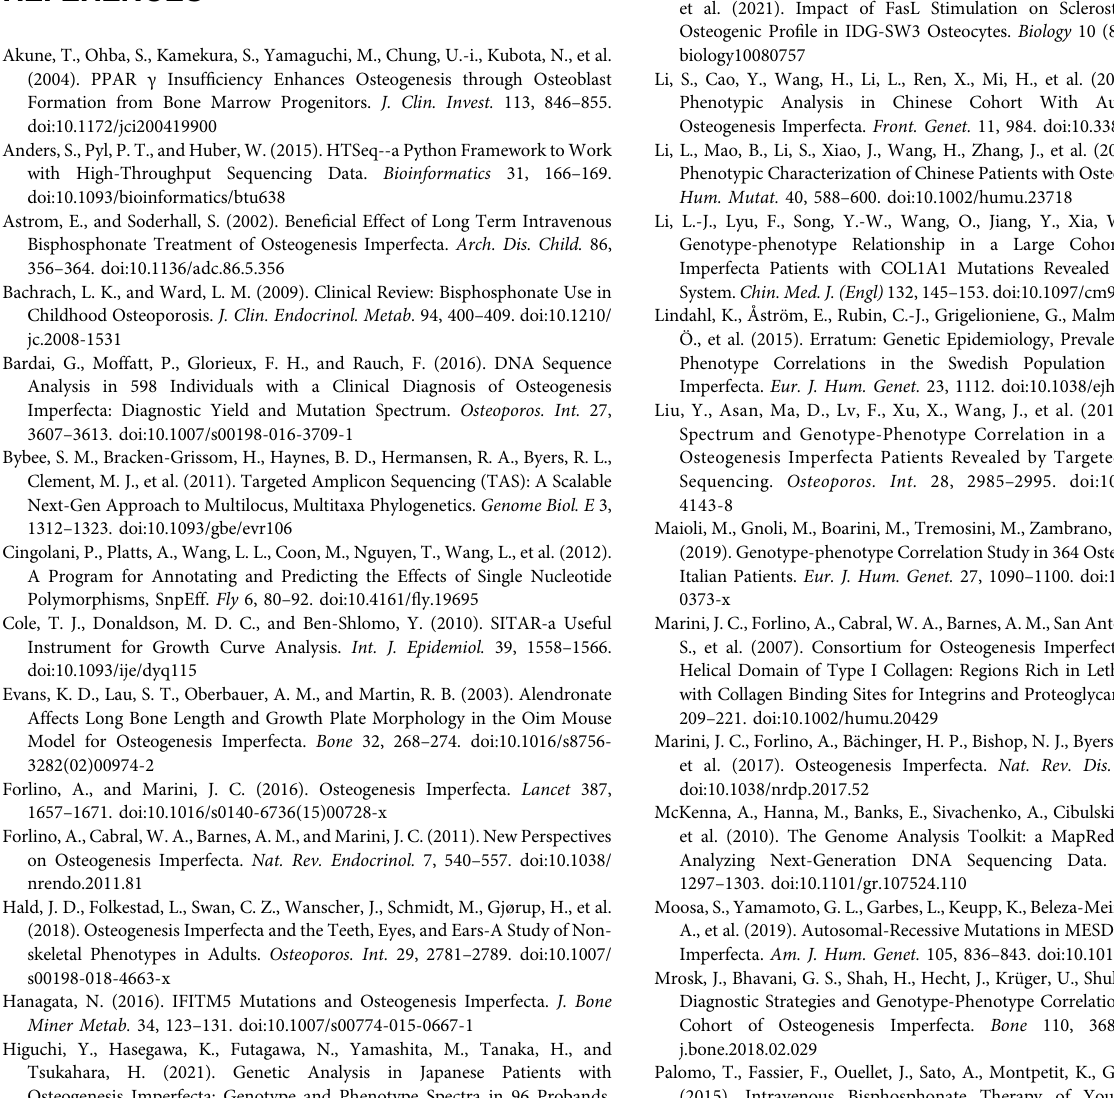
Supplementary Table S1 | A full list of the 187 patients and their genetic information. Supplementary Table S2 | Clinical features of patients with splicing mutations selected for